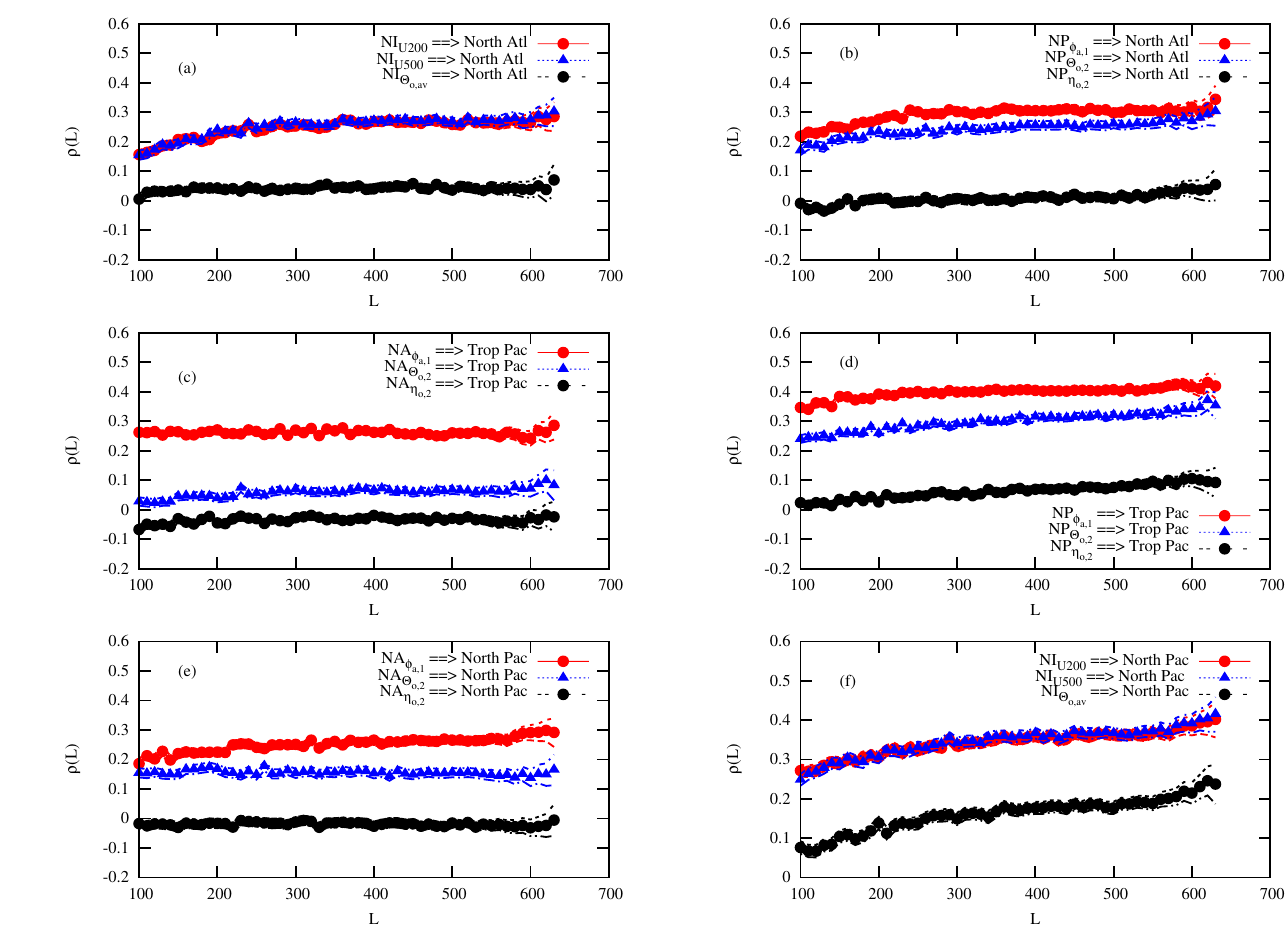
Figure 6. CCM as a function of the length L of the samples, as obtained from the monthly time series displayed in Fig. 2 for the ERA-20C and ORAS4 reanalyses. Each line with symbols corresponds to the influence of one variable on a specific coupled ocean–atmosphere basin. The specific variables are denoted in the caption corresponding to each line in each